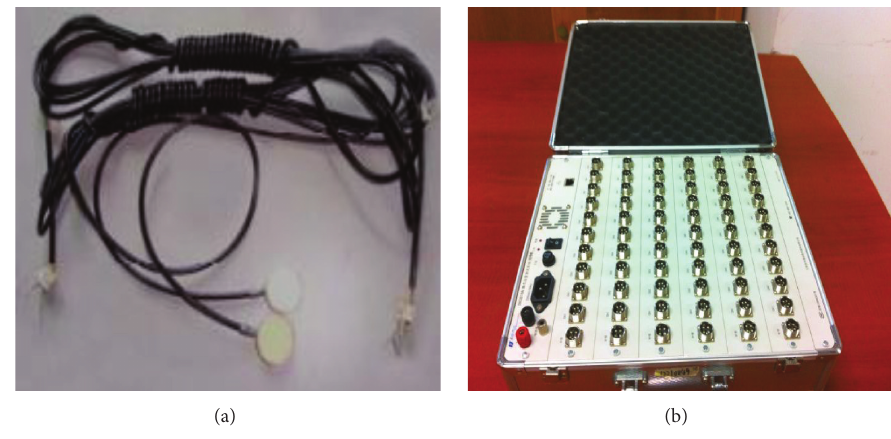
Figure 3: Data collection